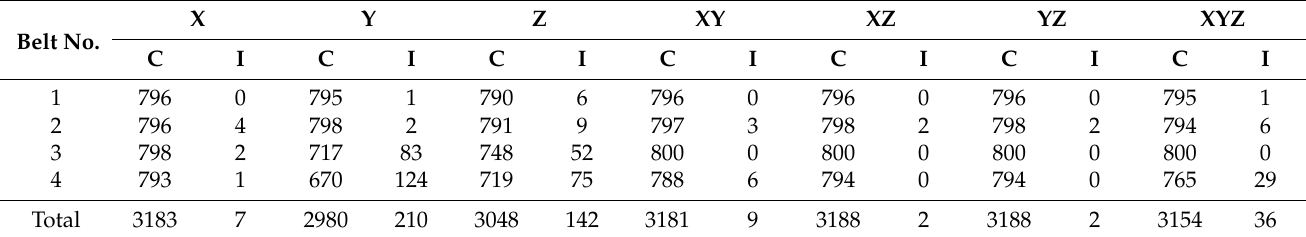
Table 15. Accuracy summary of CNN results for three-axis accelerometer and its combination. Belt No.